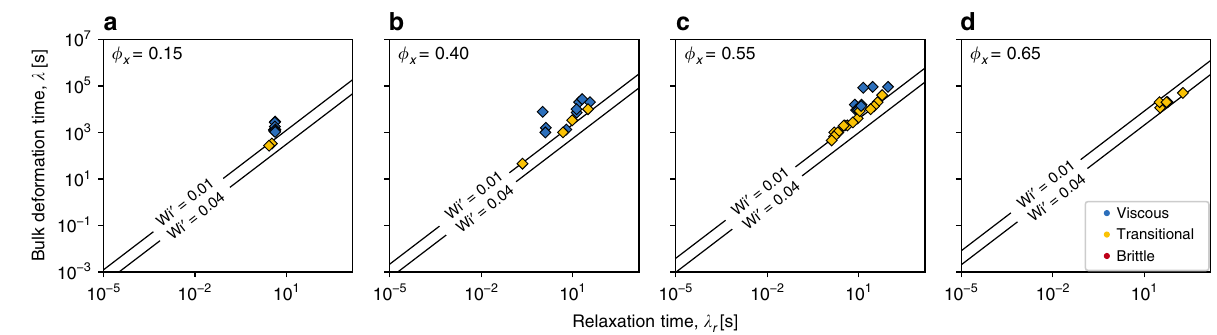
Fig. 3 Scaling approaches to account for multiphase crystal-bearing magma. Here the timescales plotted on each axis are unscaled, while the critical Wi curves are scaled for the effect of crystals in order to demonstrate how the viscous-to-brittle transition shifts with increasing crystal content ( a – d ). When the axes are scaled instead, the data should be comparable regardless of crystal effects (see Fig.